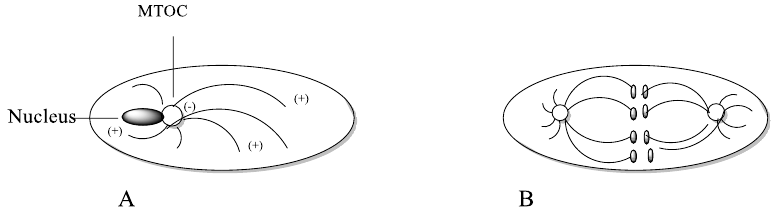
Figure 16. ( A ): Resting cell: Orientation of microtubule [60]. ( B ): Anaphase. The duplicated chro- Figure 16. ( A ) Resting cell: Orientation of microtubule [60]. ( B ) Anaphase. The duplicated chromo- mosomes attached to the microtubules are moved towards the spindle poles [5]. somes attached to the microtubules are moved towards the spindle poles